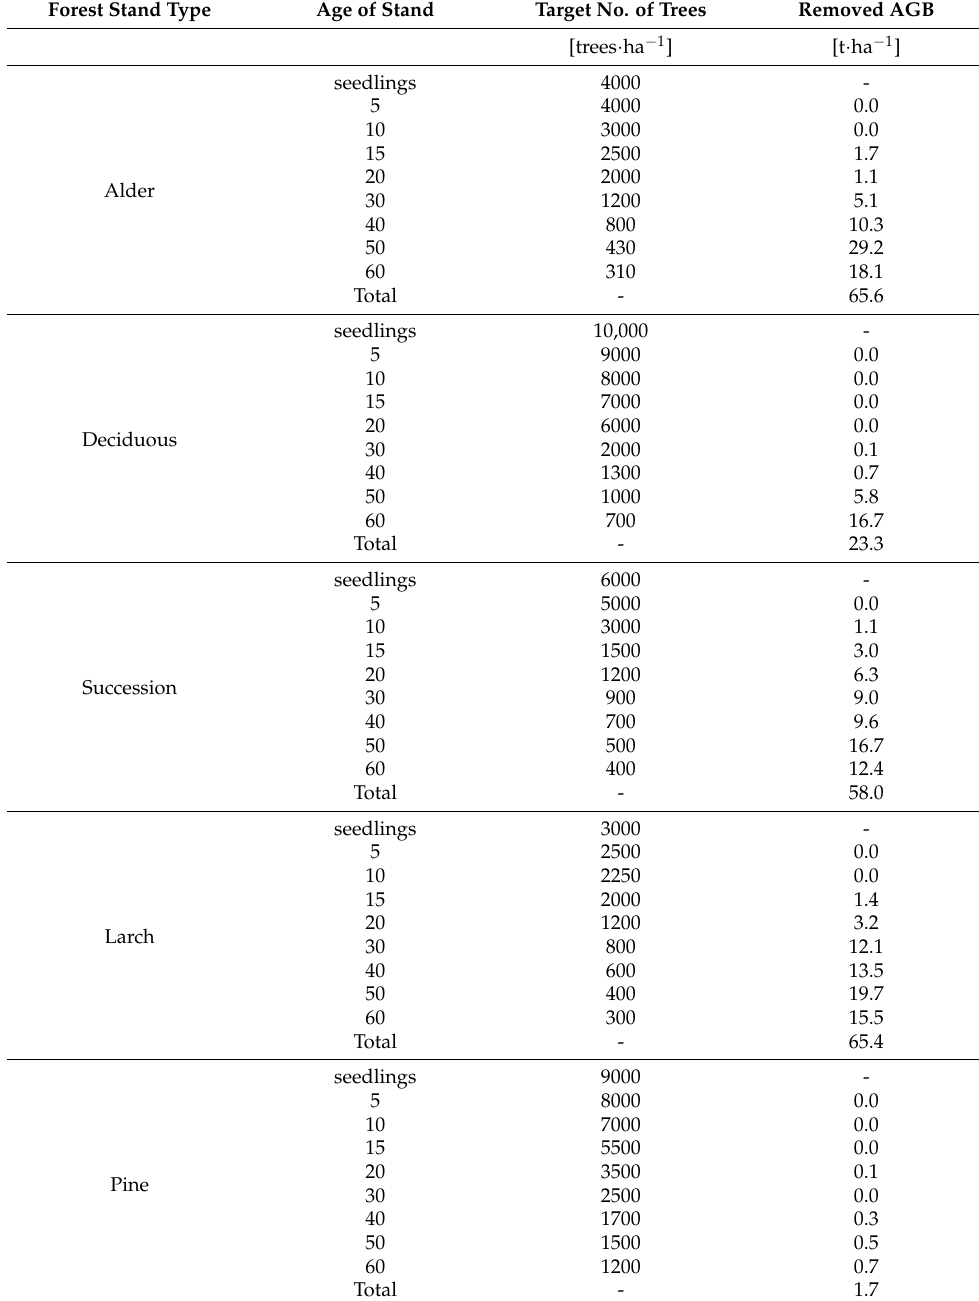
Table A7. Target number of trees and predicted stock of aboveground biomass harvested according to different thinning managements over 65